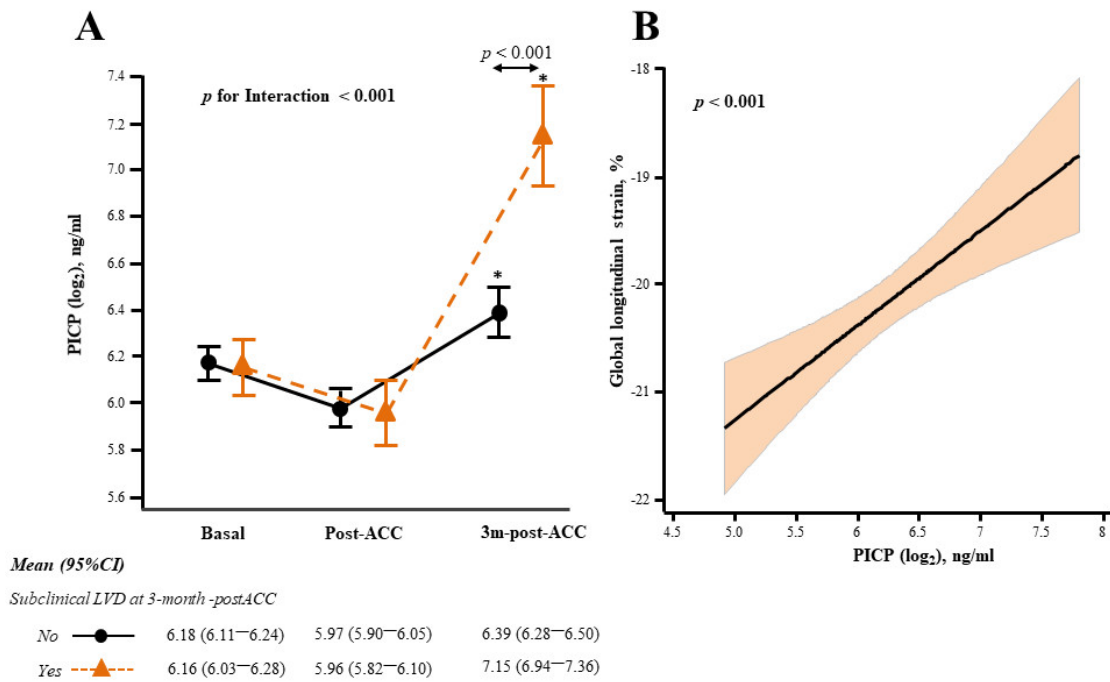
Figure 2. PICP and early cardiotoxicity in BC patients treated with ACC. ( A ) PICP circulating levels in patients with (orange triangle) or without (black circle) subclinical LVD 3 months after completion of ACC (3m-post-ACC). Data are expressed as the estimated marginal means and 95% confidence interval (CI) after linear mixed regression (LMR) analysis with PICP as the dependent variable, and subclinical LVD (yes/no), visit, their interaction term, estimated glomerular filtration rate, and PICP baseline values as fixed effects. * p < 0.001 vs baseline and post-ACC. ( B ) Association of PICP with global longitudinal strain (GLS) (solid black line) and 95% confidence intervals (color shade) throughout the treatment up to 3m-post-ACC after multivariable LMR with adjustment as explained in the main text. PICP, procollagen type-I C-terminal propeptide; BC, breast cancer; ACC, anthracycline-based cancer chemotherapy; LVD, left ventricular dysfunction.